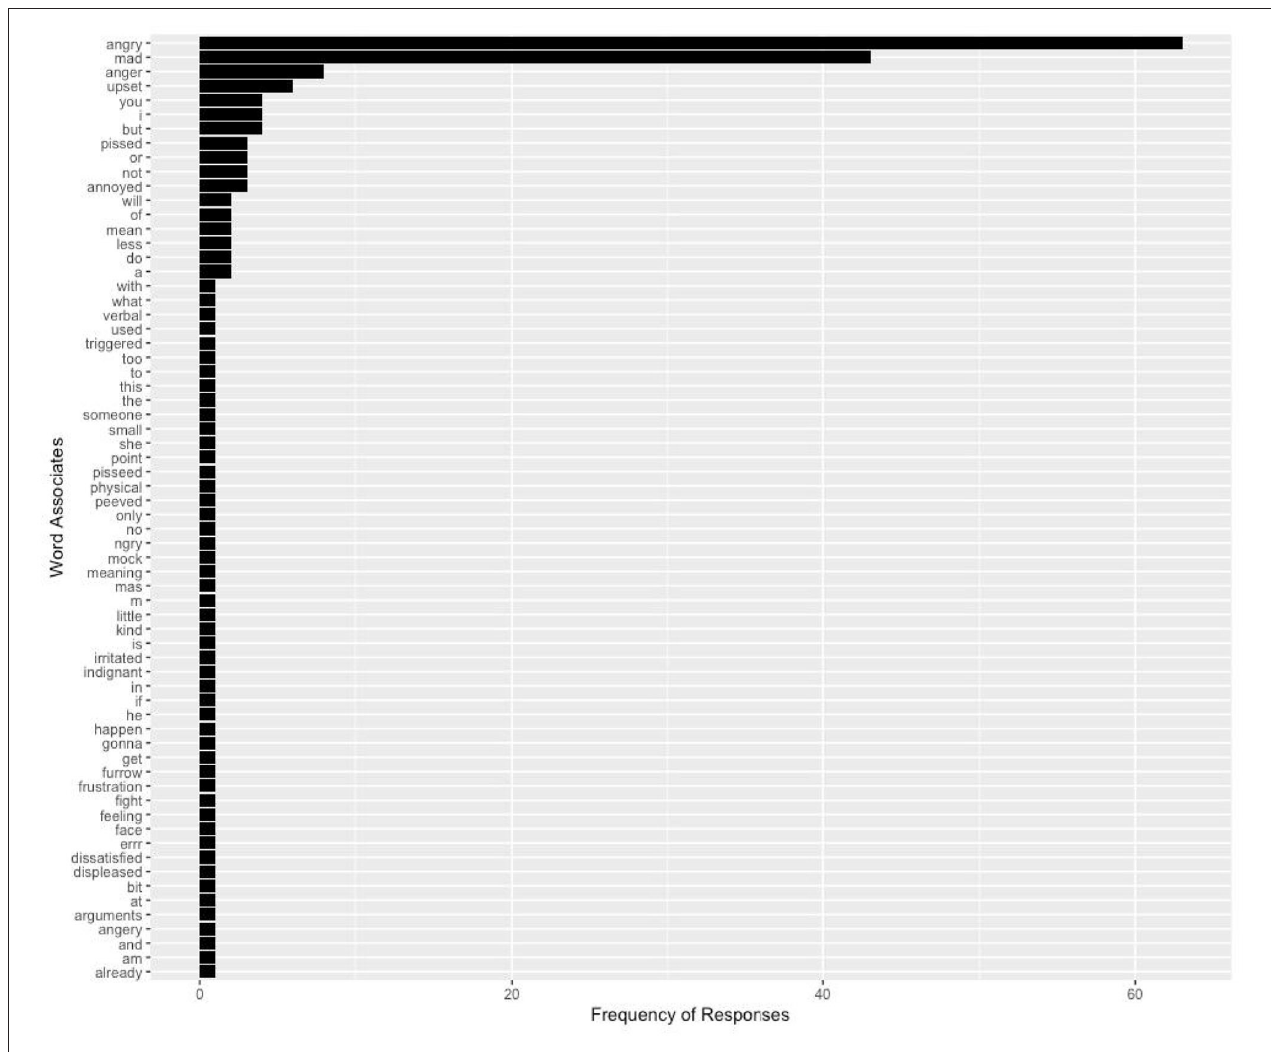
FIGURE 3 | Word associations produced in response to (angry face). Note that the word responses here have not been filtered to remove stopwords (e.g., “to”) nor have they been modified (e.g., to correct spelling errors).